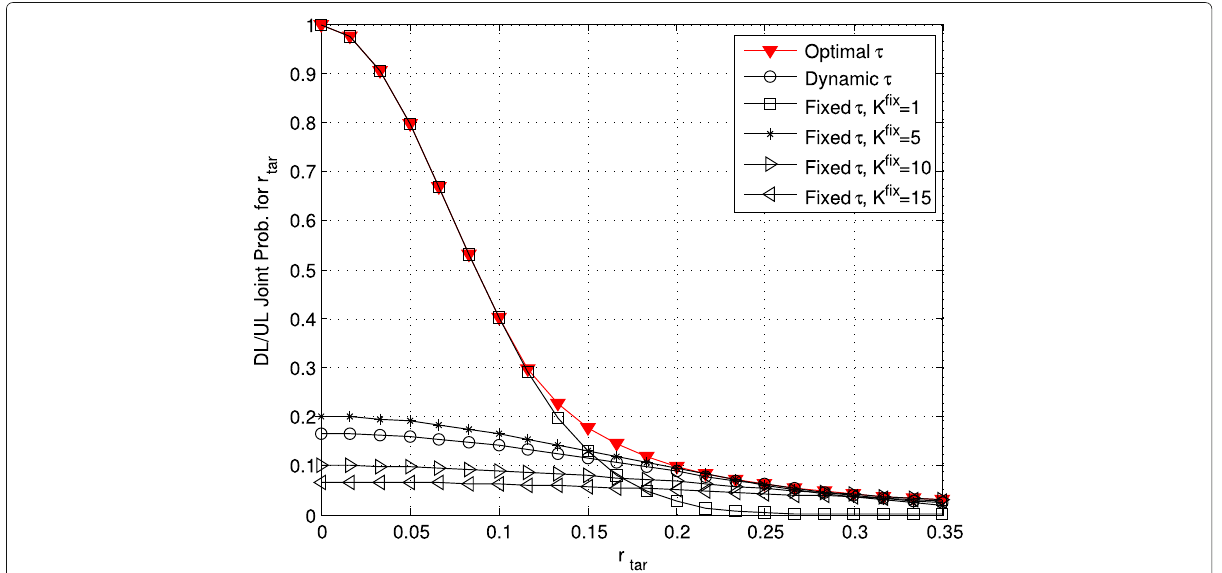
Fig. 5 DL/UL joint probability for varying target distance with the different SA-AC schemes when T d ( dB ) = − 10 and T u ( dB ) = 0. The proposed SA-AC scheme with optimal TP is shown to be the best by reflecting the spatial effect